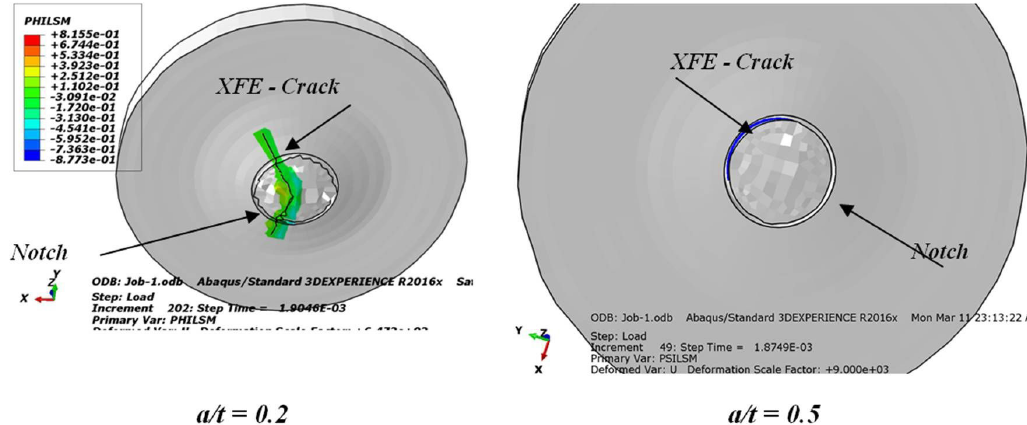
Figure 21. Site of crack initiation and crack path of CBN specimen with a/t = 0.2 and